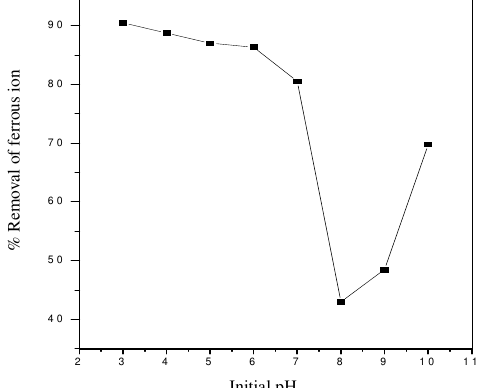
Figure 5. Effect of pH on the adsorption of ferrous ion onto ZDC [M] = 15 mg/L; contact time = 60 min; adsorbent dose = 25 mg/ 50